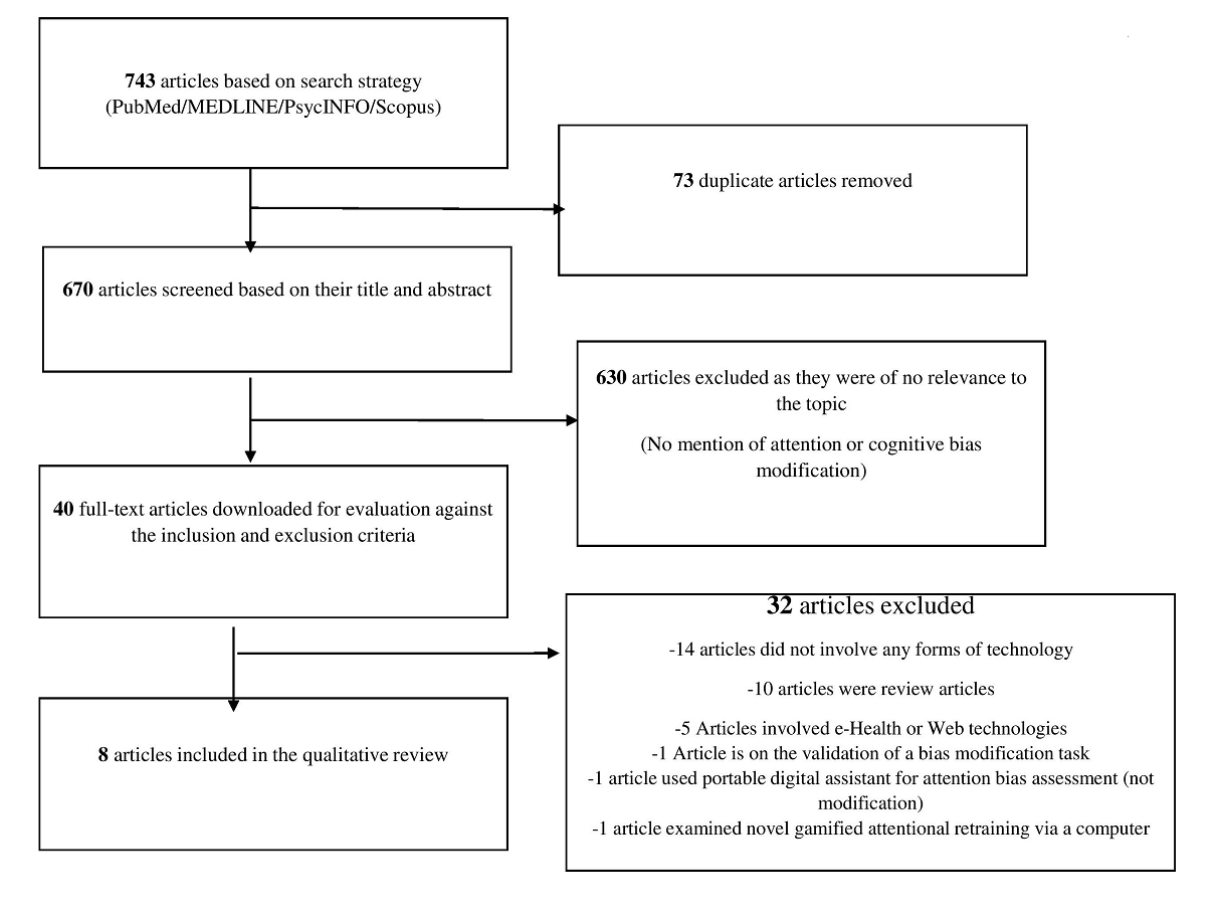
Figure 1. Flowchart of article